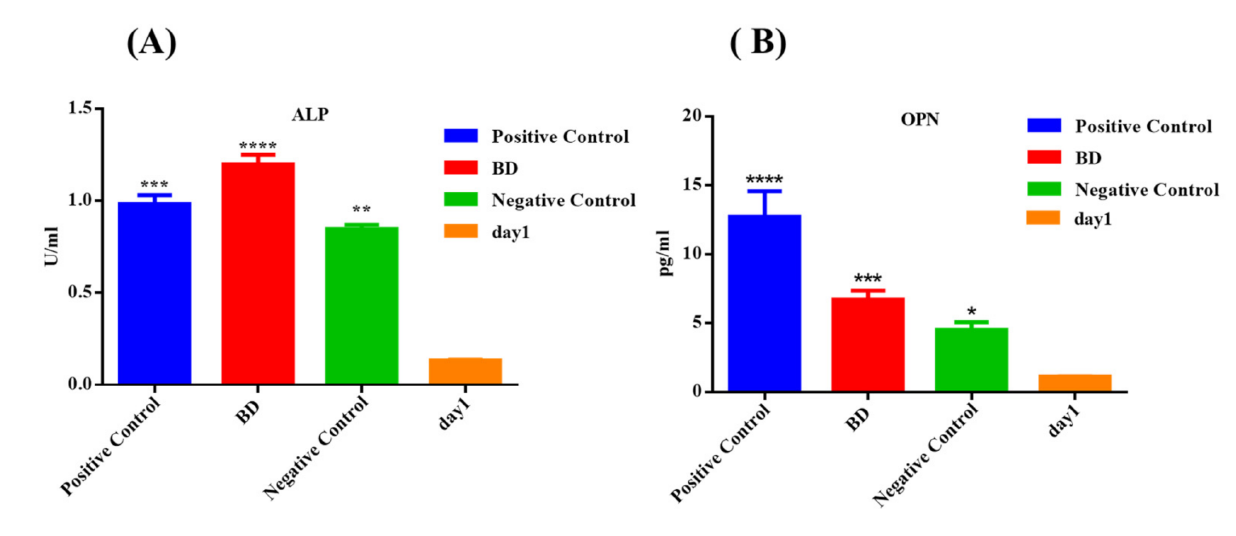
Figure 5. Measurement of odonto/osteogenic markers concentration ( A ) ALP and ( B ) OPN, secreted by DPSCs treated with Biodentine, odonto/osteogenic differentiation media (positive control), and uninduced cells cultured in their own growth media (negative control), after 3 weeks of treatment by ELISA. (**** p < 0.00005, *** p < 0.0005, ** p < 0.005, * p < 0.05).